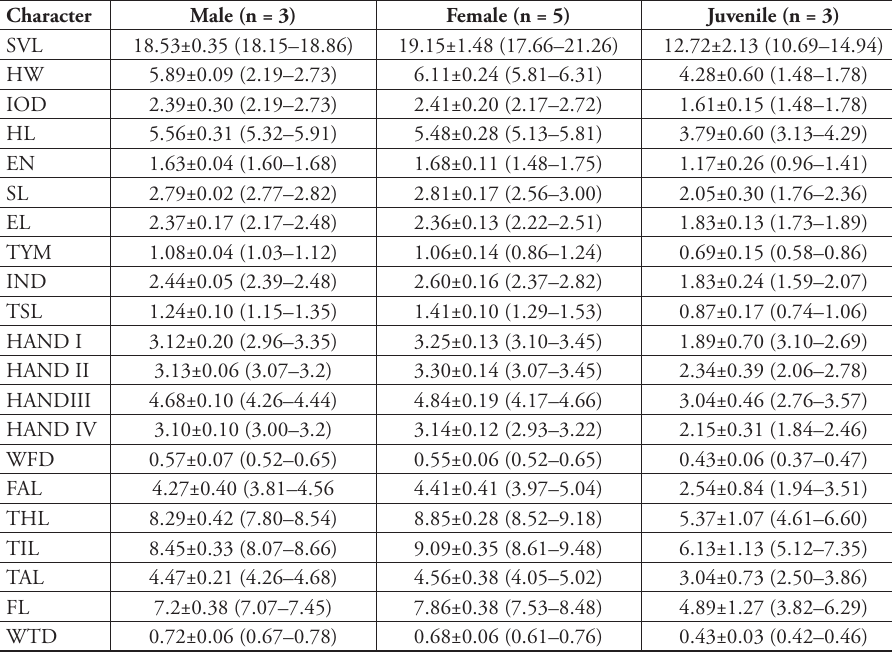
Table 1. Morphometric measurements (in mm) of the type series of Anomaloglossus meansi sp. n. Abbre- viations are defined in the text. Means ± SD are followed by the range in